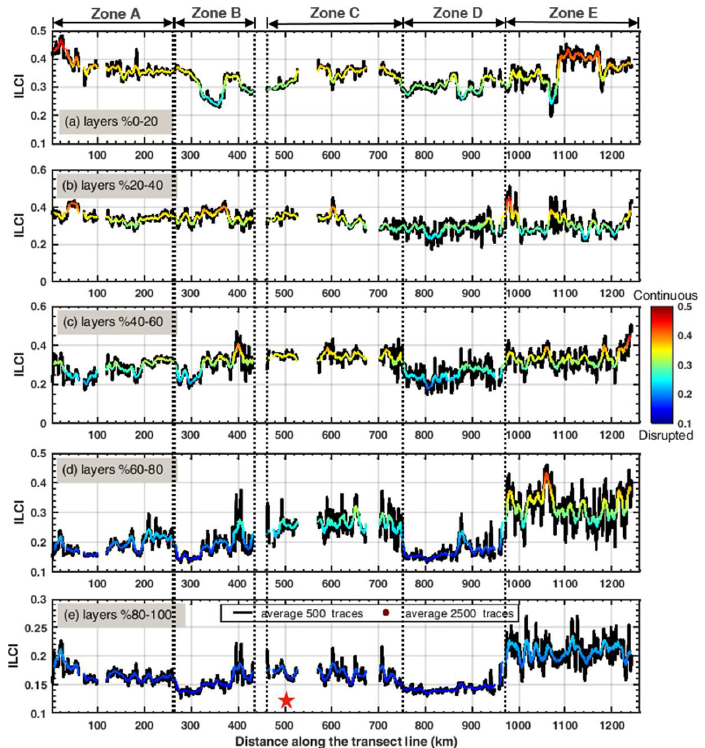
Figure 4. ILCI graph of depth range from Zhongshan to Dome A. ( a – e ) show the results derived progressively at the decline in each fifth of the ice. The black line indicates the result of 500-trace moving windows, and the color scatter is the result of 2500-trace moving windows. The red star marks the location of Taishan Station.